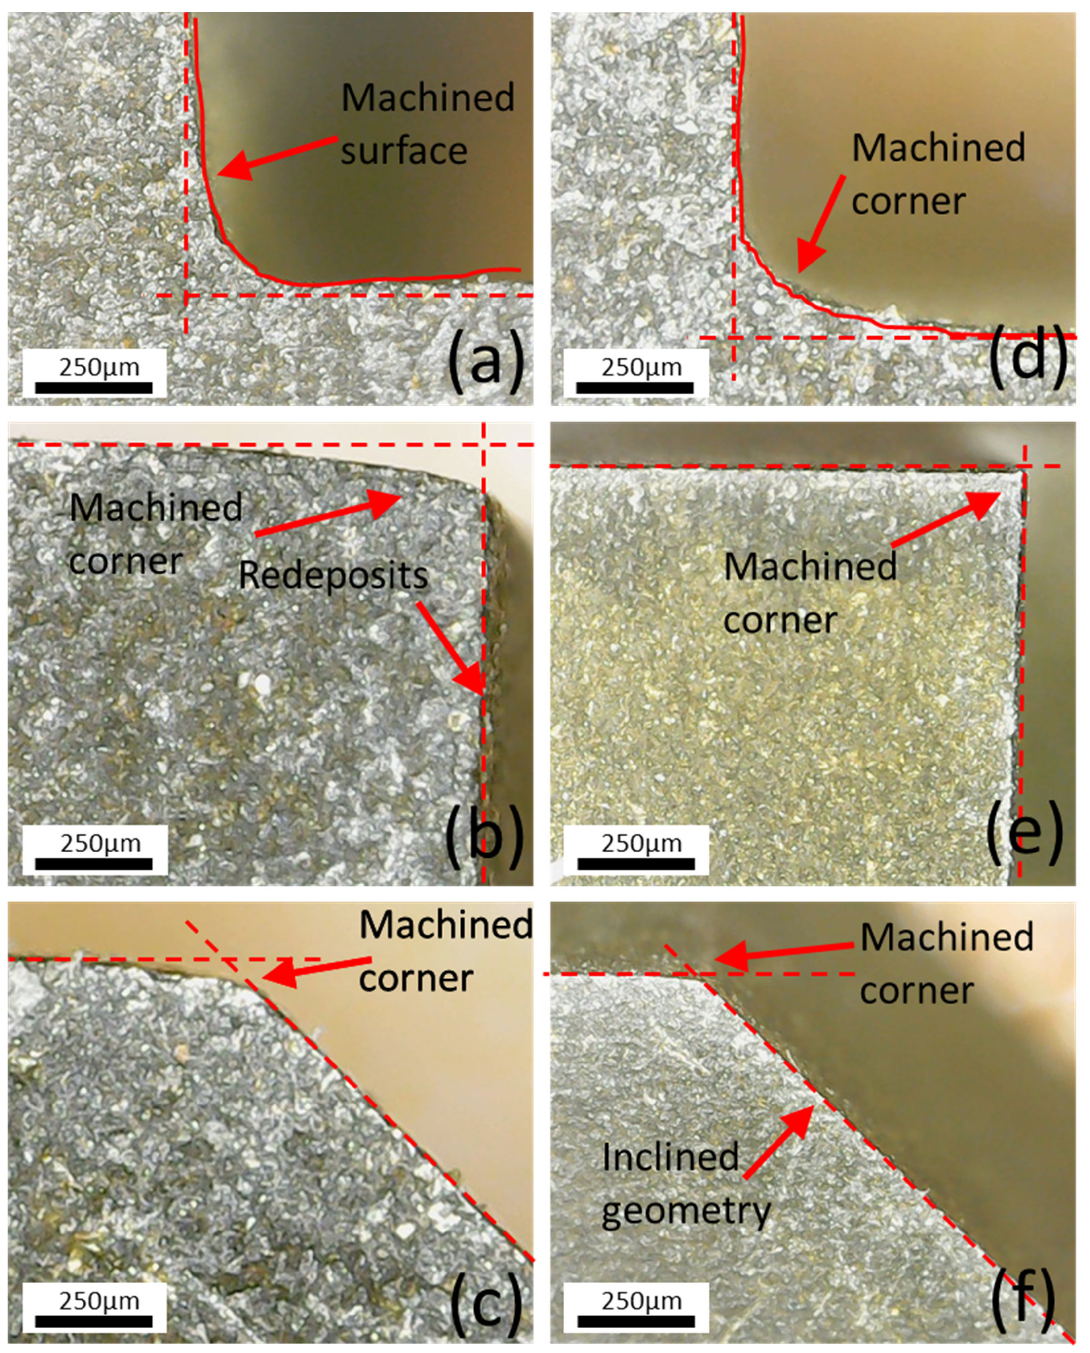
Figure 12. Angular deviation and corner formation: ( a – c ) V S 40 V, F P 12 kg/cm 2 , Ø N 4 mm, and W D 10 mm (un-optimized); ( d – f ) V S 50 V, F P 4 kg/cm 2 , Ø N 8 mm, and W D 10 mm (optimized).